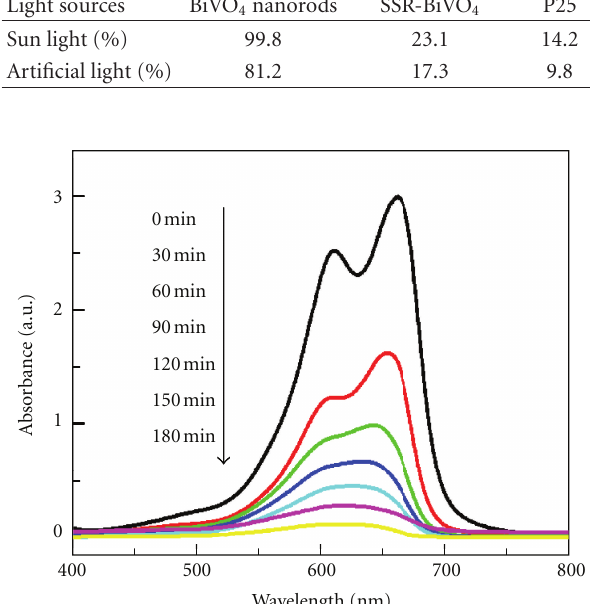
Figure 7: Temporal spectral changes of the MB in BiVO 4 nanorods solution under sunlight irradiation; experimental conditions are otherwise identical to those of sunlight-irradiation BiVO 4 disper- sion in Figure